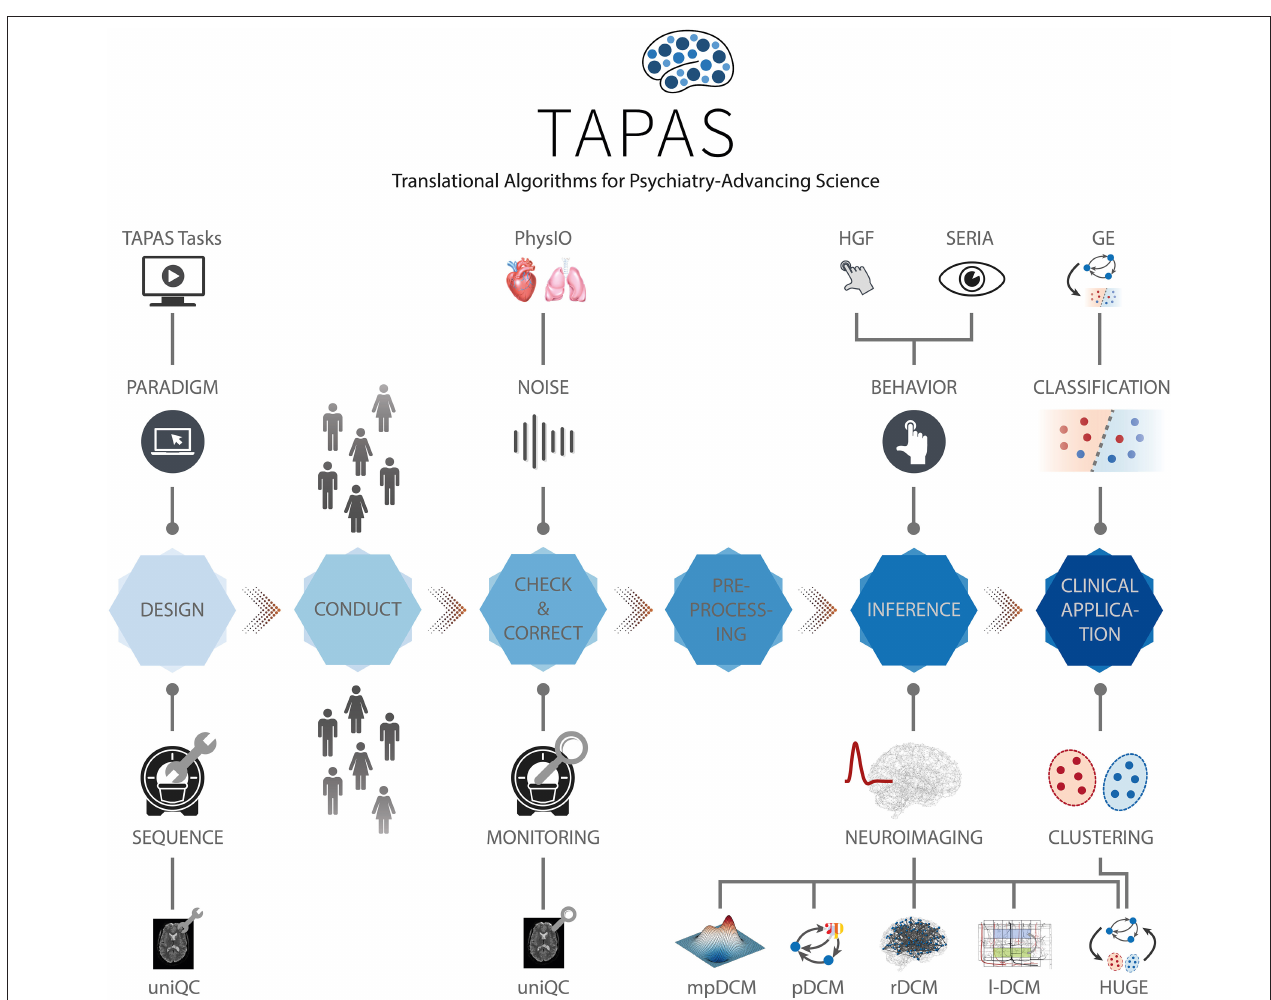
FIGURE 2 | TAPAS components in a proposed end-to-end pipeline of a clinically relevant computational assay. This end-to-end pipeline will need to incorporate all steps from the raw imaging or behavioral data to a final clinical recommendation. Such a computational assays will capture at least the following crucial